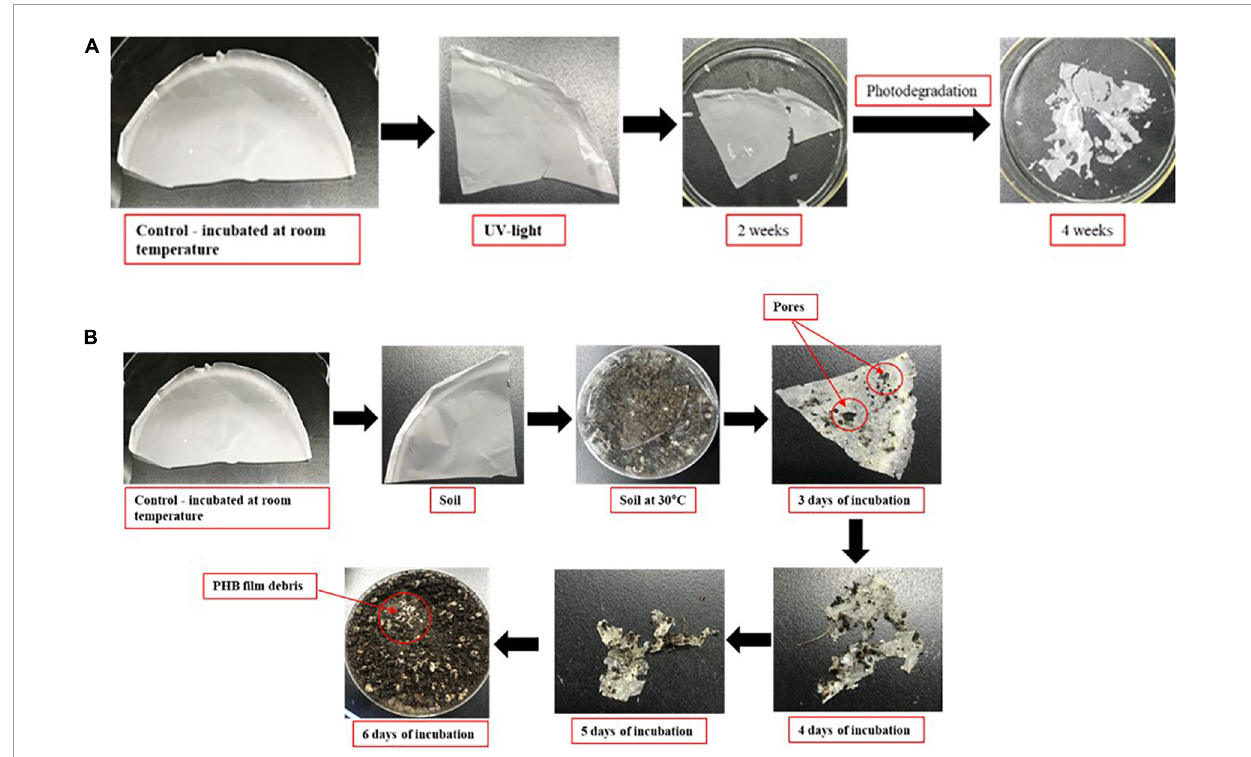
FIGURE8 Degradation of PHB in UV-light exposure (A) . Degradation of PHB after 7 days of incubation at 30 ◦ C under soil collected from nearby field (B)